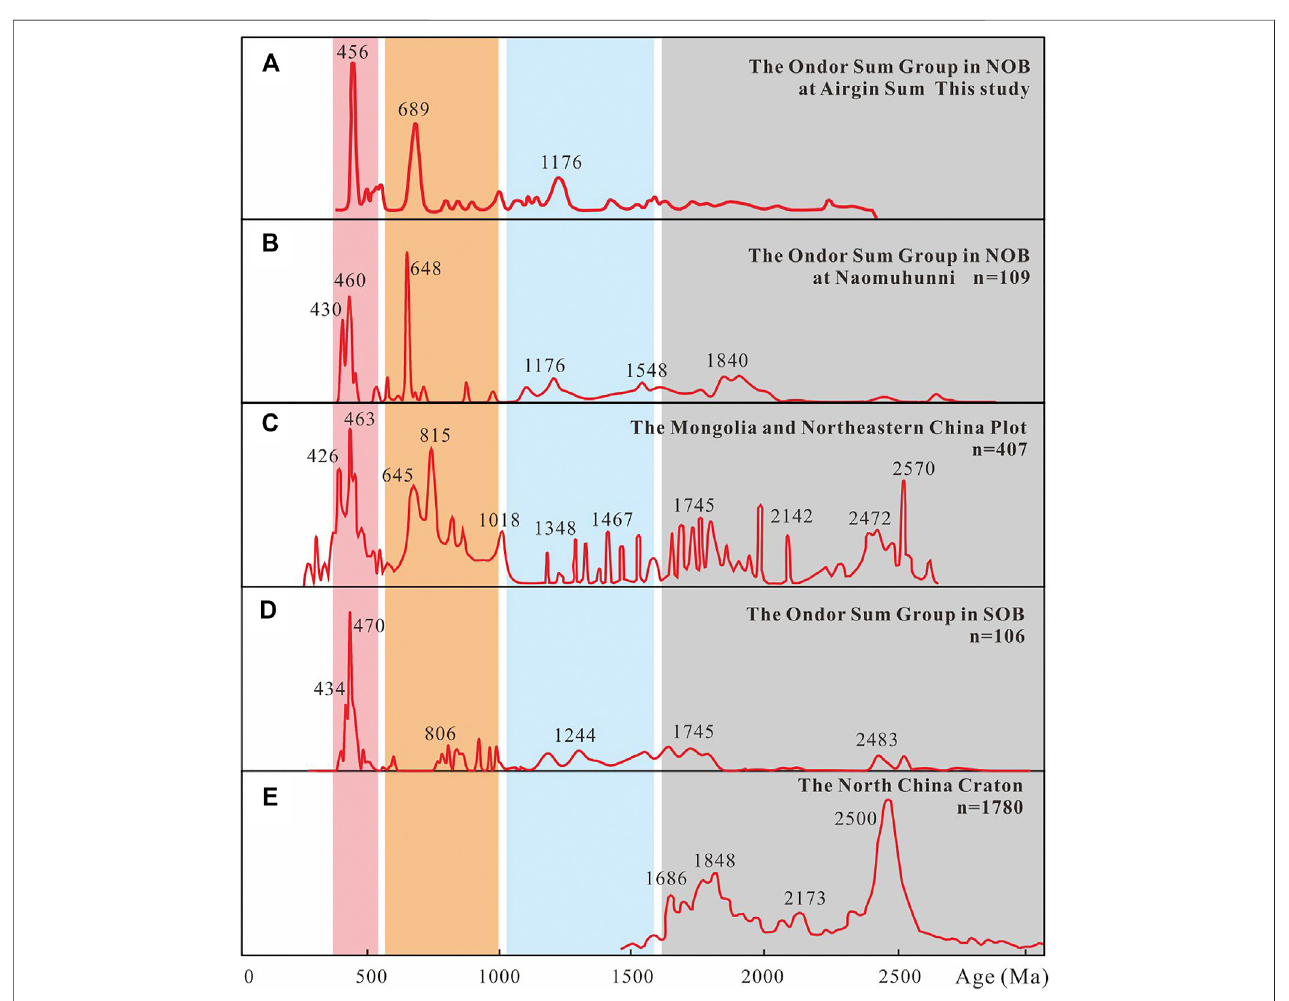
FIGURE 12 | Relative probability diagrams showing age distribution of Ondor Sum Group in central Inner Mongolia (A,B,D) , the Mongolia and Northeastern China Plot (C) and the NCC (E) . Data are cited from Zhou and Wilde (2013), Zhou et al. (2014), Xu et al. (2013, 2014), and Rojas-Agramonte et al. (2011).